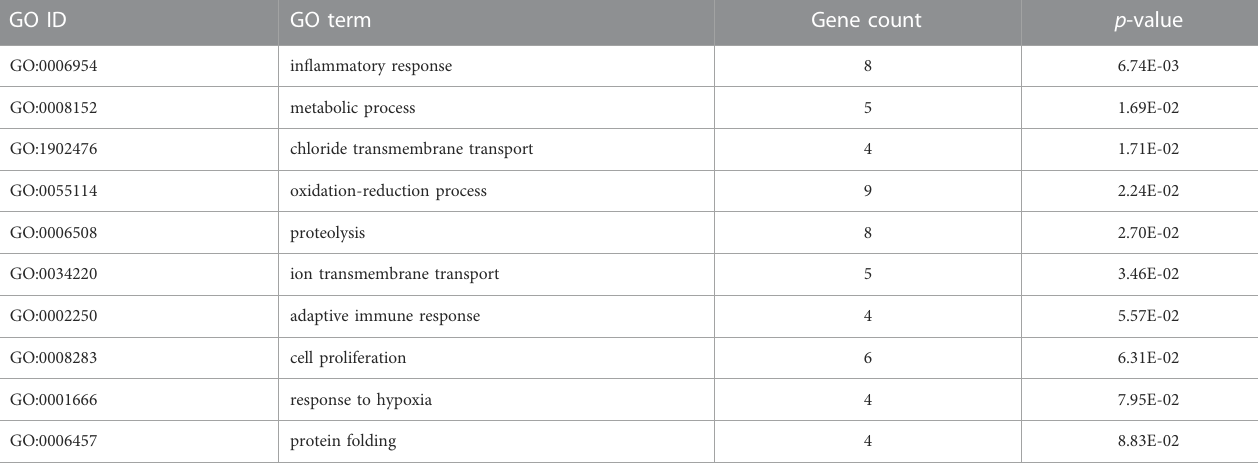
TABLE 4 Biological process GO terms of differentially expressed transcripts in common between the cortisol vs. mifepristone/cortisol groups. GO ID